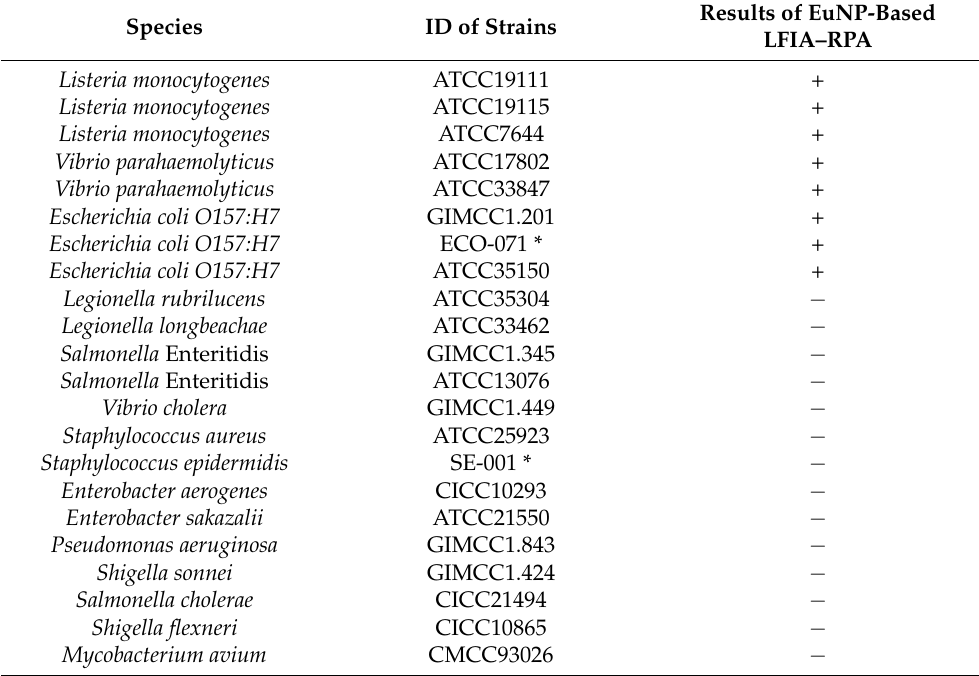
Table 1. Information on bacterial strains used in this